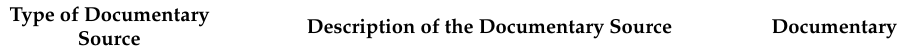
Table 1. The di ff erent documentary sources